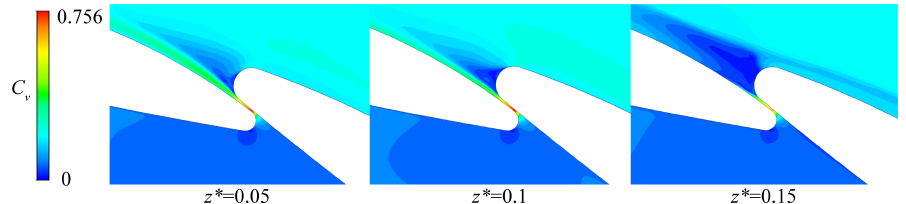
Figure 9. The velocity distribution near the narrow gap between two guide vane blades at different guide vane